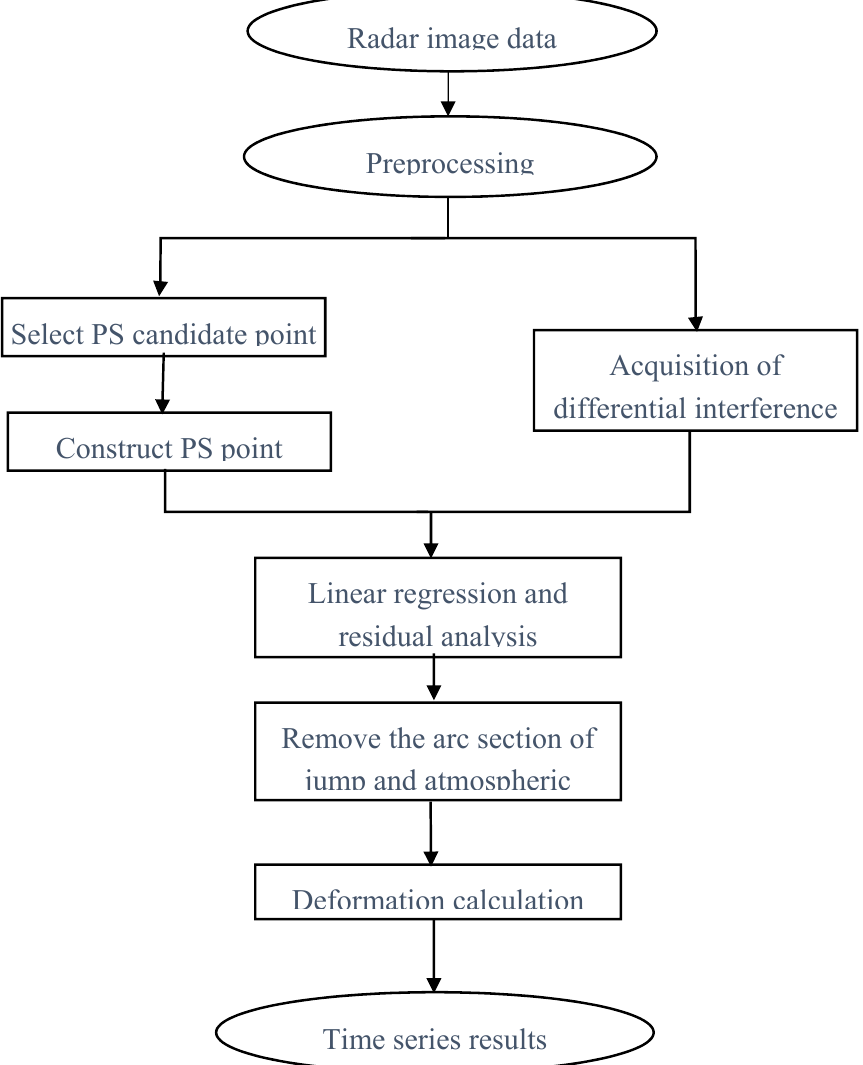
Figure 5. Time sequence processing flow of ground-based real aperture radar